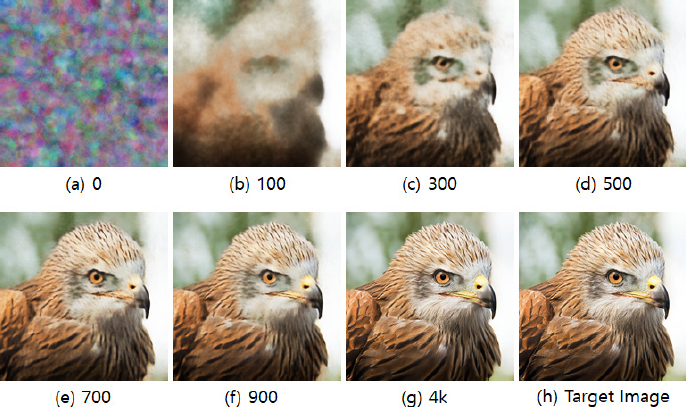
Figure 3. Image reconstruction by the number of DIP iterations.